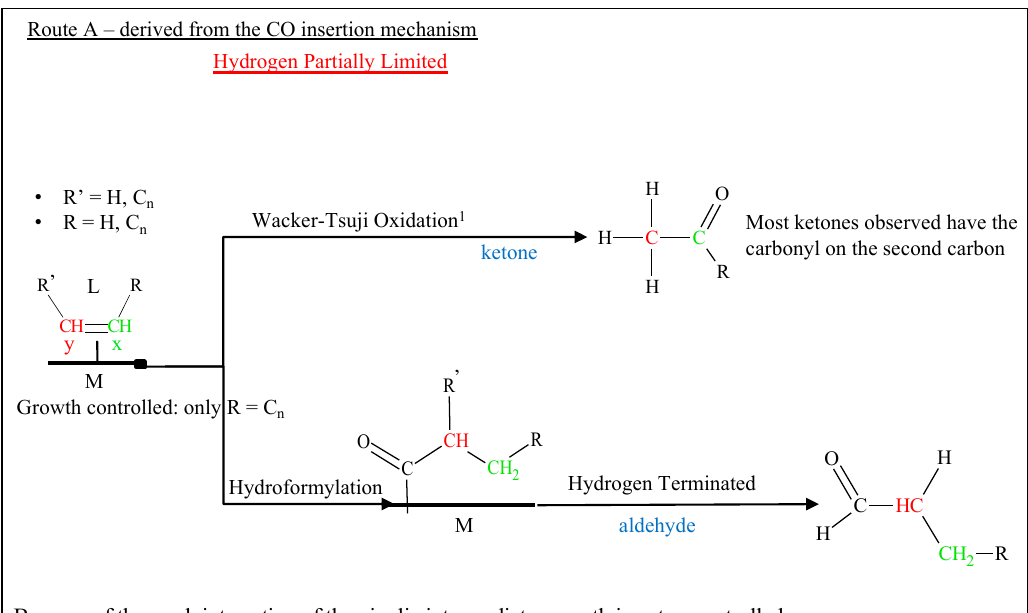
Figure 42. Proposed route A for the formation of several products observed in FTS, based on the CO insertion mechanism (Figure 38).